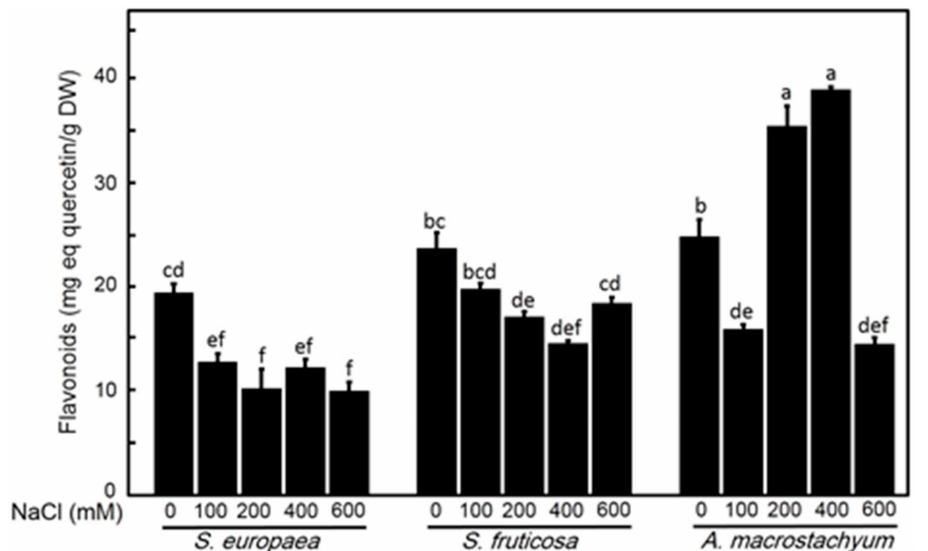
Figure 10. Total flavonoids contents of S. europaea, S. fruticosa and A. macrostachyum under different NaCl concentrations. Mean ± SE of three replicates. Different letters indicate significant differences ( p <